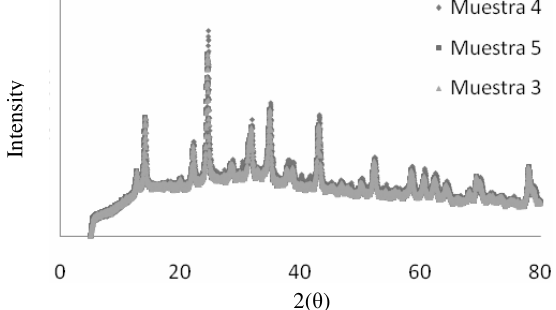
Figures 16. Comparison of the diffractograms of samples 3, 4 and